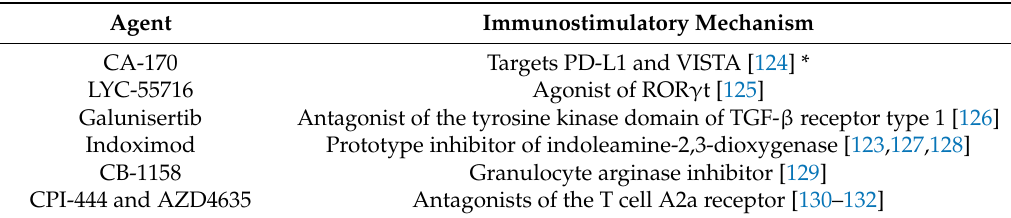
Table 5. Novel, low-molecular weight, pharmacological immunostimulants which may augment immunogenic cell